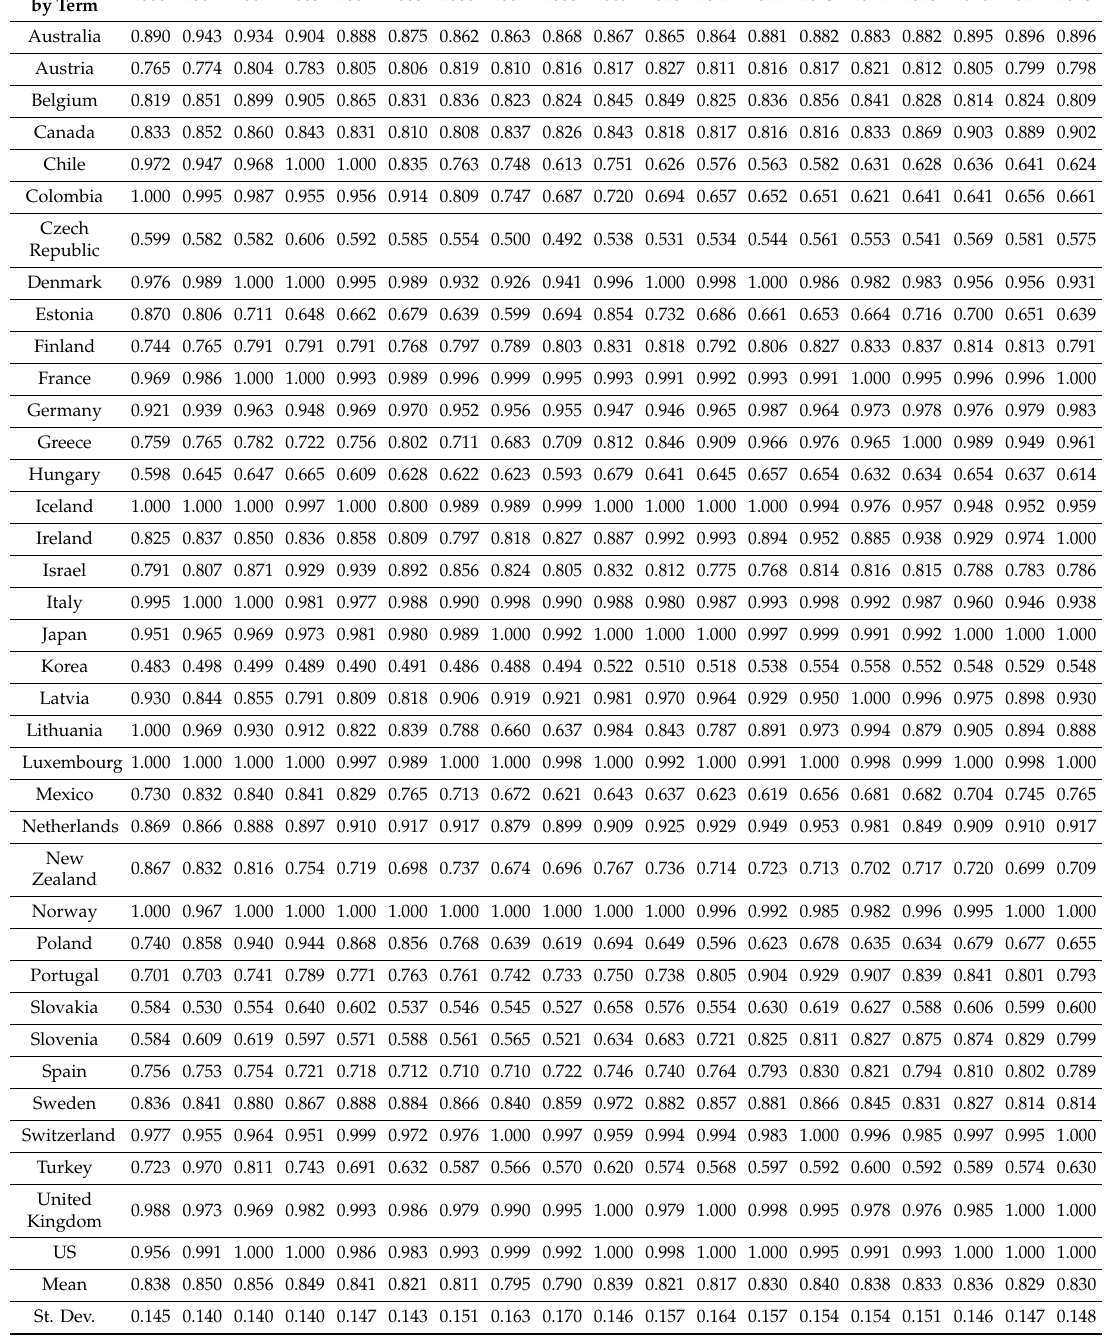
Table 5. Total factor energy e ffi ciency means for 5-year window ( w = 5)